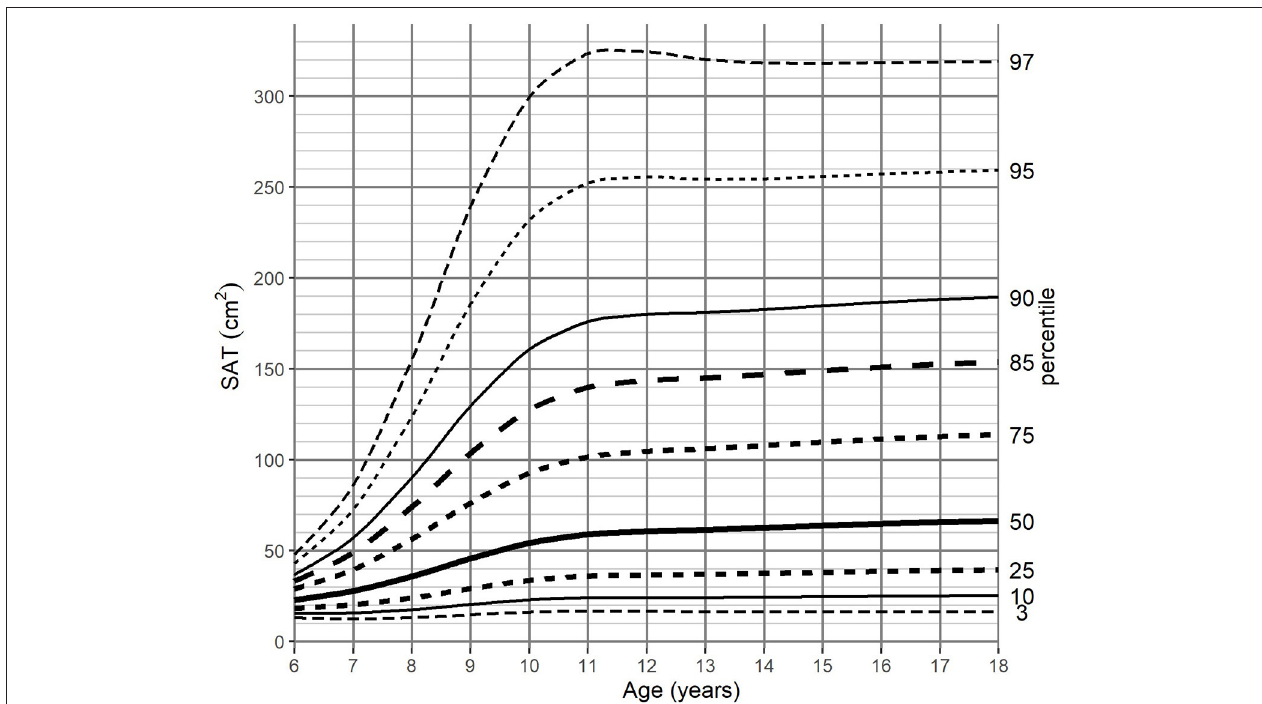
FIGURE 2 | SAT-for-age (cm 2 ) percentile charts for boys aged from 6 to 18 years. SAT, subcutaneous adipose tissue.